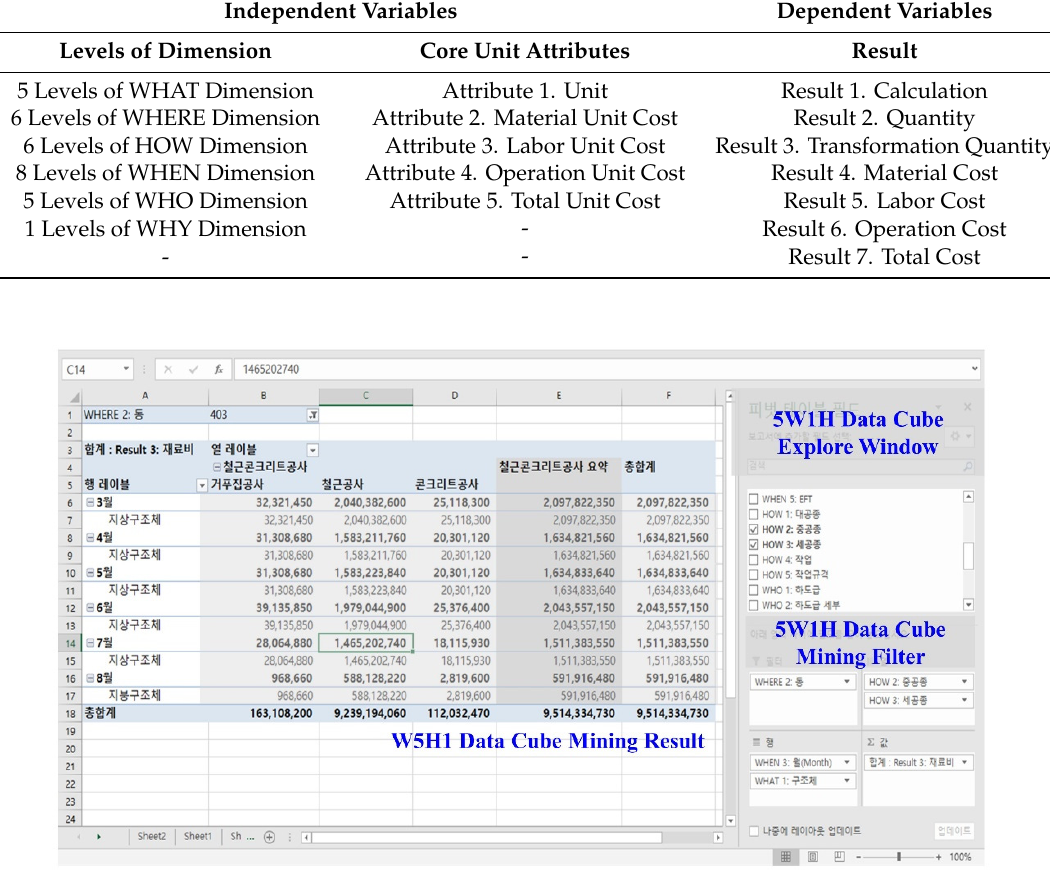
Figure 9. Interface of Data Mining and Analysis Modules using Pivot Table in Excel.